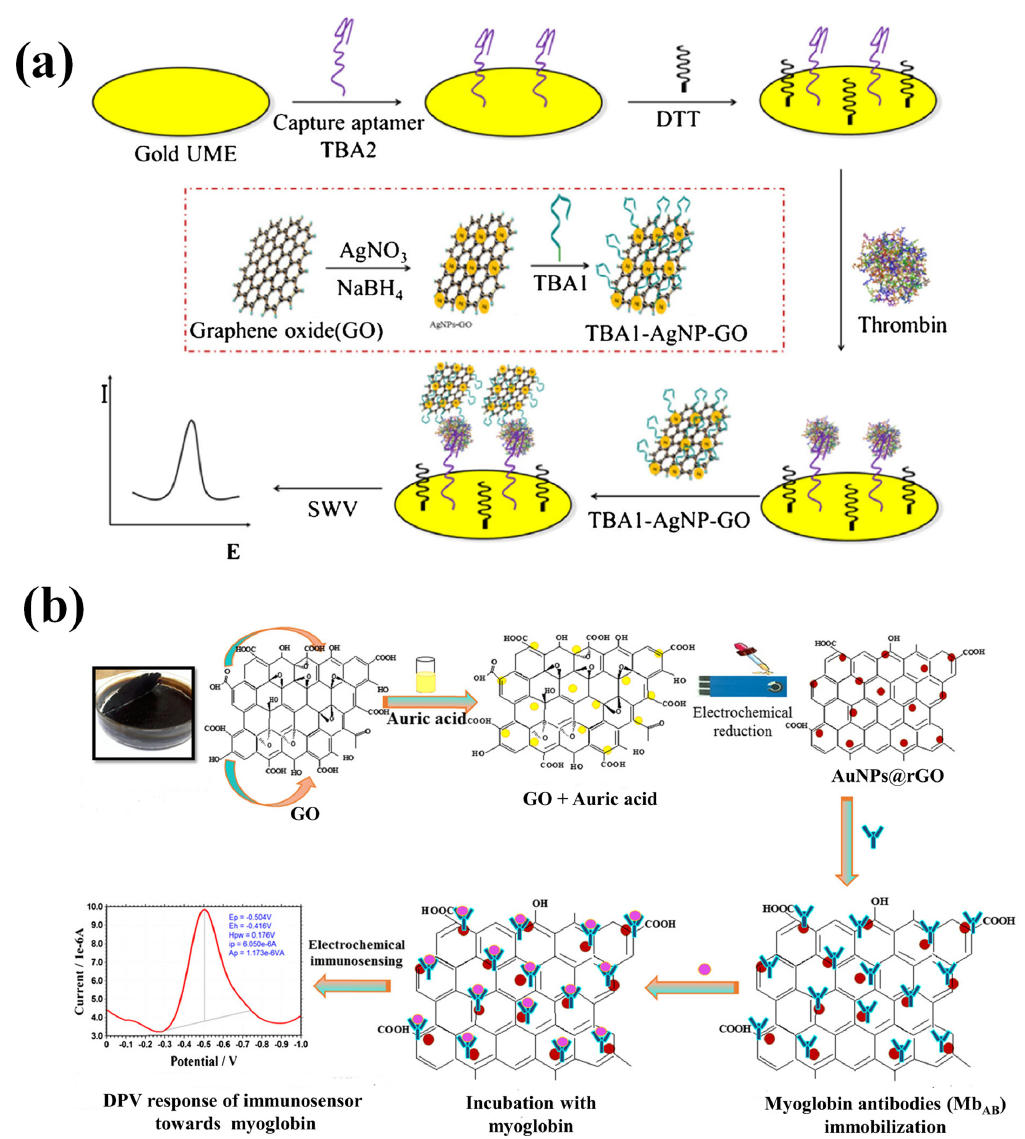
Figure 8. ( a ) Pictorial representation of an electrochemical aptasensor for thrombin using gold